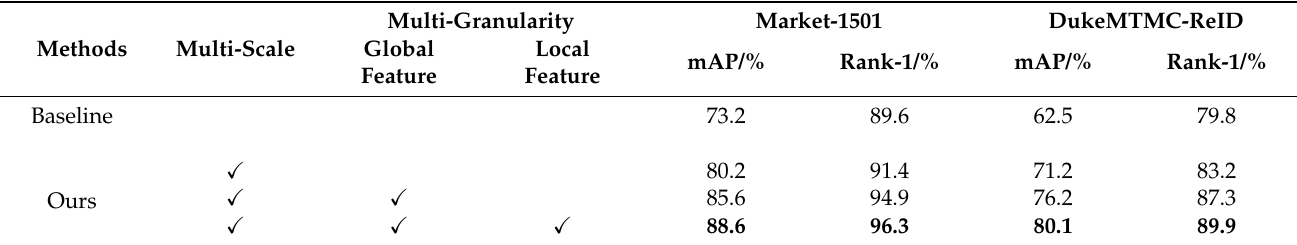
Table 2. Validity verification of each branch.